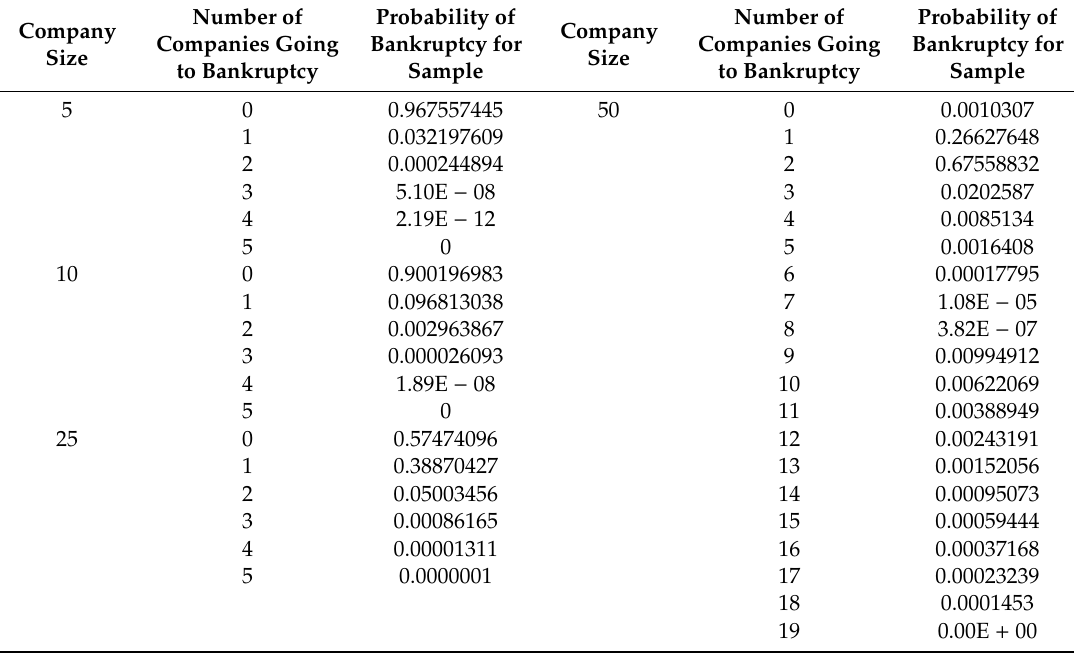
Table4. Resultsforthesimulationforpoolingarrangementsofdi ff erentcompanysizeswithprobabilities of